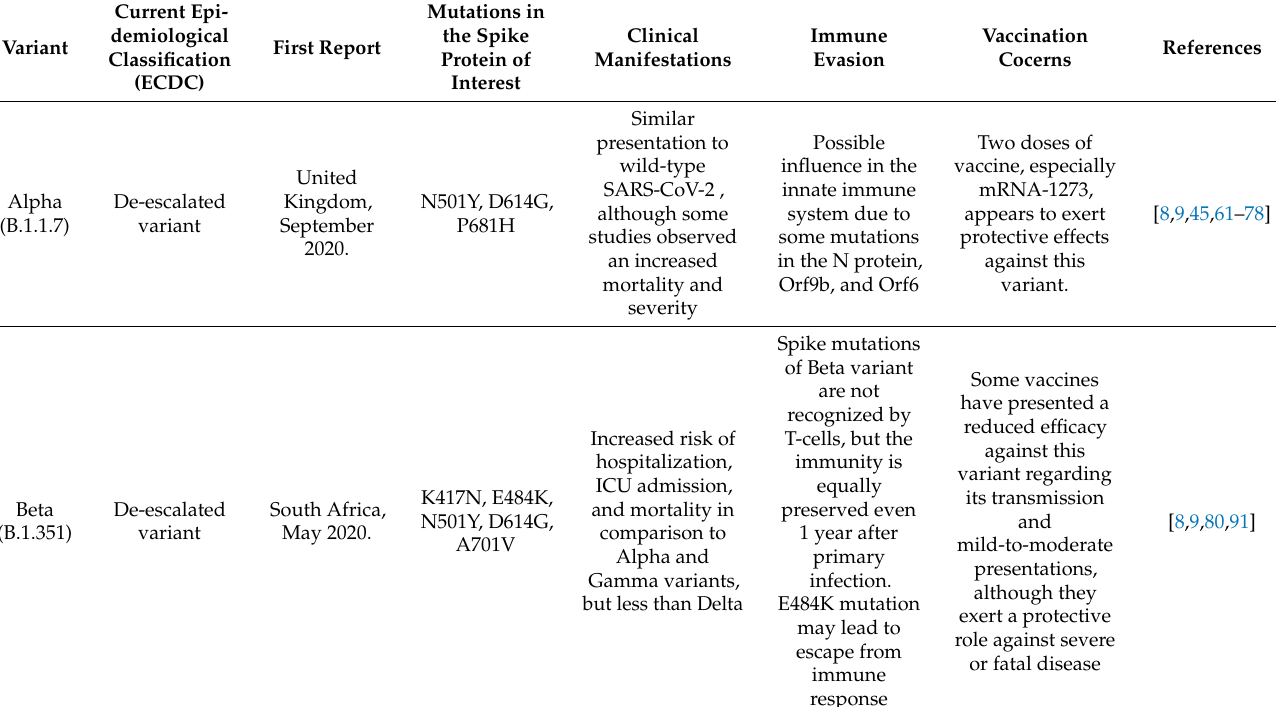
Table 1. A summary of the main SARS-CoV-2